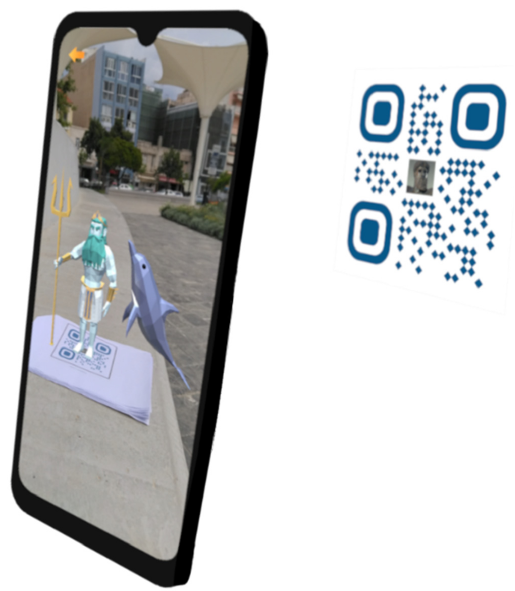
Figure 3. Scanning the target image.